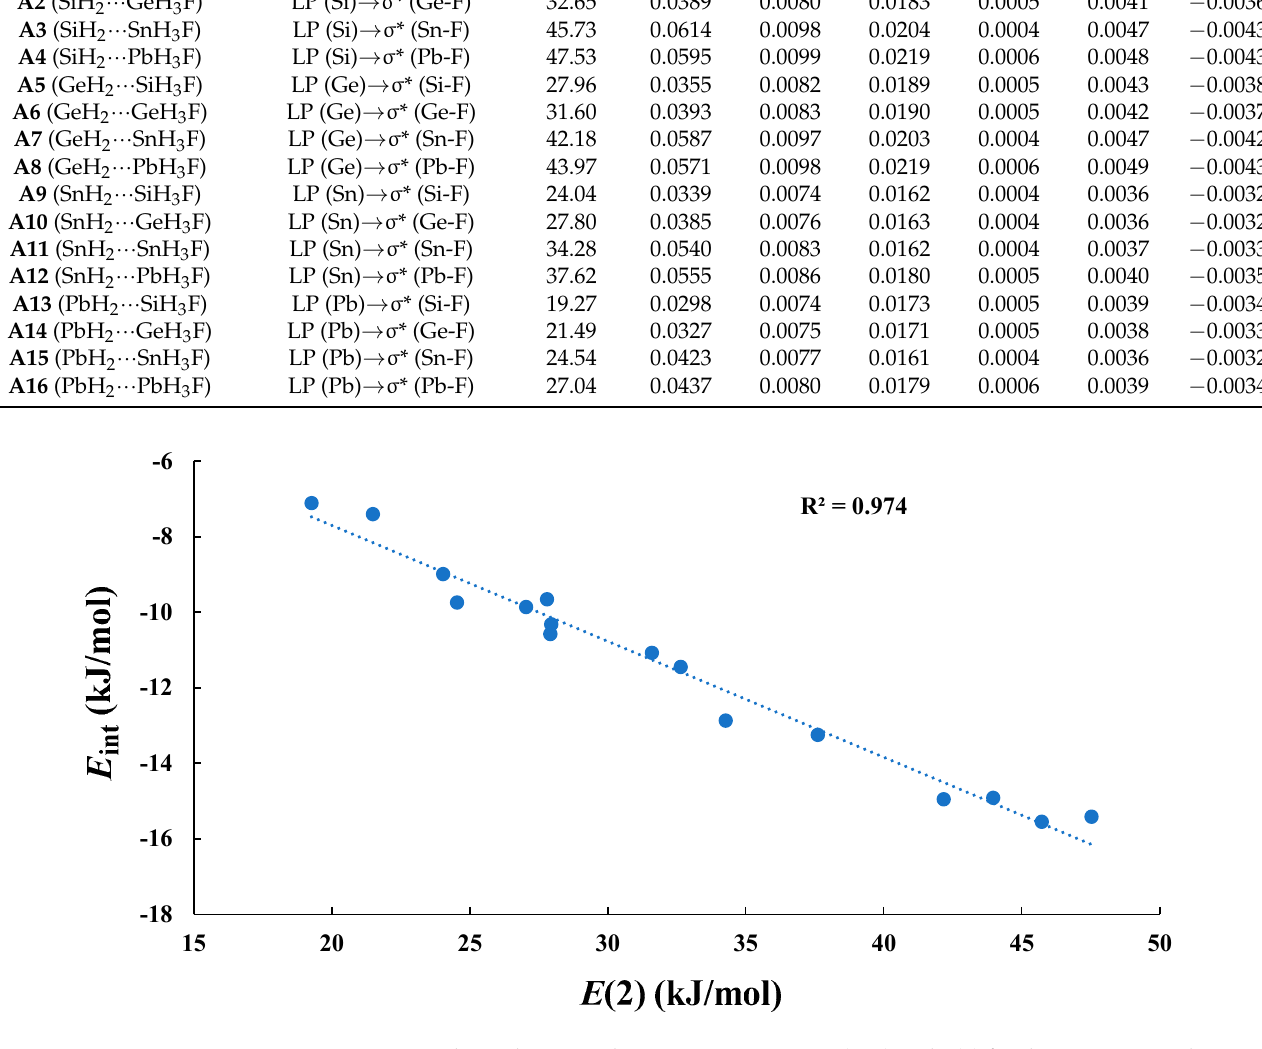
Figure 6. Correlation between the interaction energies ( E int ) and E (2) for the type-A complexes. The optimized geometries of the type-B complexes ( B1 – B8 ) involving TH 2 with N 2 and HCN are shown in Figure 8. The formation of the complex SiH 2 ··· N 2 ( B1 ) was confirmed by the experimental study [61]. It should be noted that N 2 is a rather weak Lewis base, and therefore the formation of B1 reflects the high reactivity of SiH 2 as a Lewis acid. The T ··· N binding distances range from 2.175 to 2.736 Å for the TH 2 ··· N 2 complexes ( B1 – B4 ), with the N-N ··· T binding angles ranging from 171.3 ◦ to 179.5 ◦ . The complexes B1 – B4 possess larger E int values ranging from − 14.59 to − 26.08 kJ/mol, with larger WBI values ranging from 0.104 to 0.289, compared with the type-A complexes. Like N 2 , HCN also uses the lone